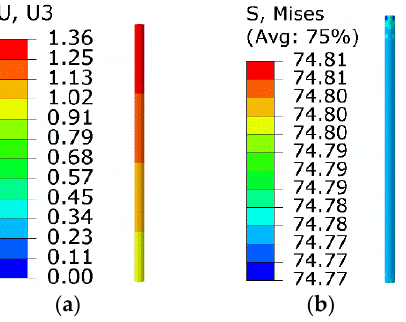
Figure 6. Results of step 4: ( a ) axial displacement; ( b ) equivalent stress.